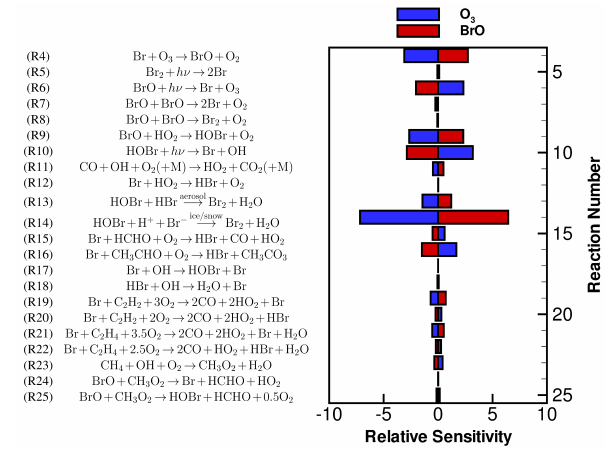
Fig. 13. Instantaneous relative sensitivities of O 3 and BrO concen- trations at day 4 for a boundary layer height of